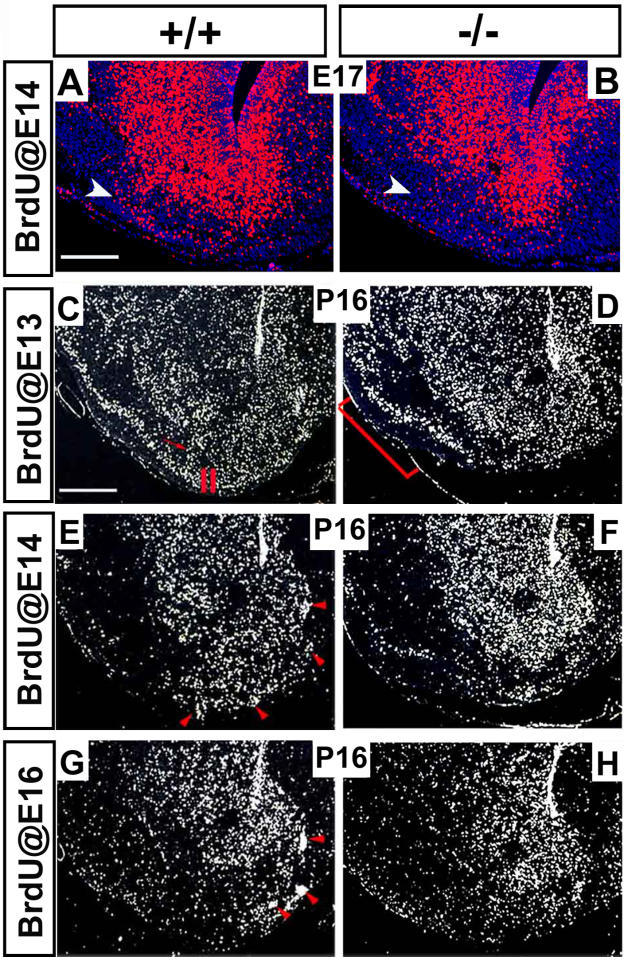
Failure of Neurons to Migrate to the VS in the Absence of SOX1This figure shows BrdU labeling of proliferating cells in the developing forebrain. Immunohistochemistry was performed on 5-μm coronal sections, cut at the level of the OT.(A and B) Sections at E17, after BrdU injection at E14. White arrowheads in (A and B) indicate streams of migrating cells.(C–H) Sections at P16, after BrdU injection at E13 (C and D), E14 (E and F), or E16 (G and H). The DAB reaction product (C–H) was viewed under dark-field illumination. “II” is layer II of the OT, and the red bracket indicates the olfactory cortex. Note E13-born neurons contribute laterally to the olfactory (piriform) cortex, and medially to the layer II of the OT and the striatal bridges (red arrow). E14-born neurons contribute to more medial VS structures than E15- and E16-born cells, which contribute almost exclusively to the medial islands of Calleja (red arrowheads).Scale bar = 300 μm (A and B), 1 mm (C–H).